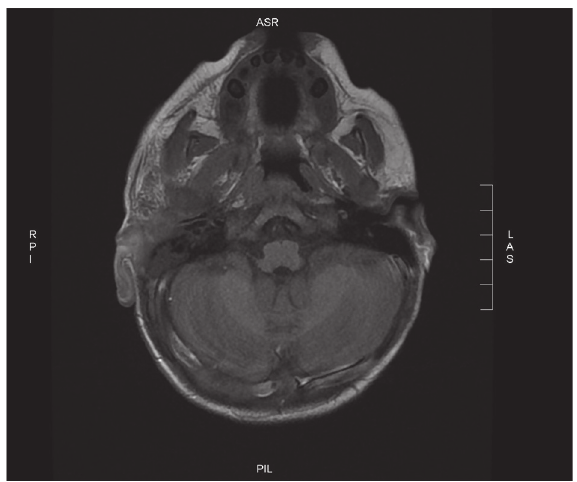
Figure 3: T2 MRI with no contrast showing significant inflam- matory changes in the right ear canal, periauricular region.